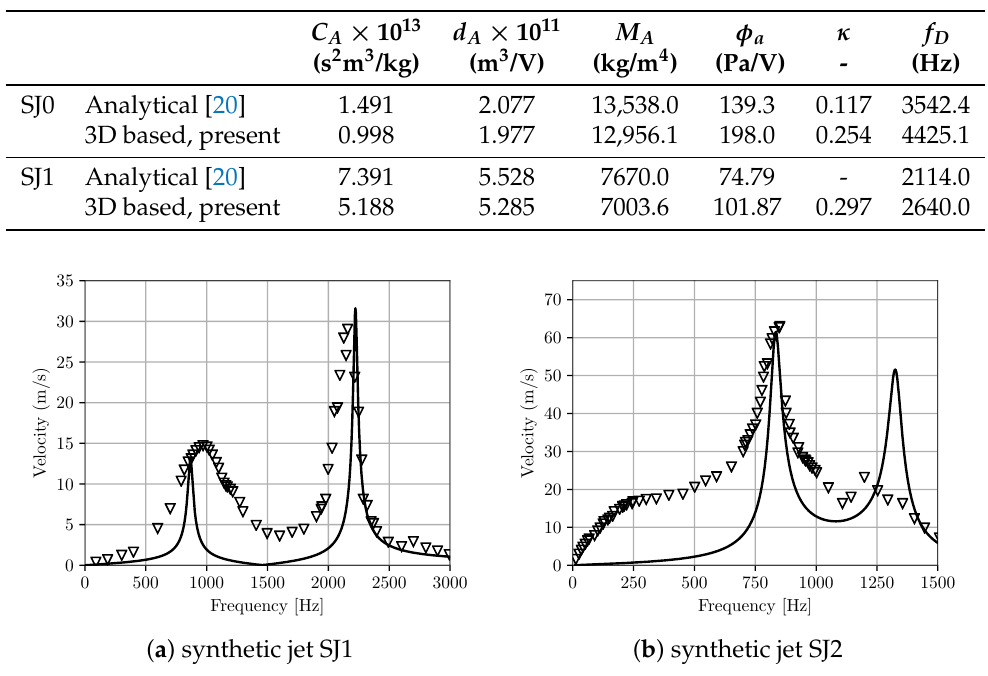
Table 4. LEM parameters for different synthetic jet configurations using the 3D simulation based approach and analytical estimation [20].